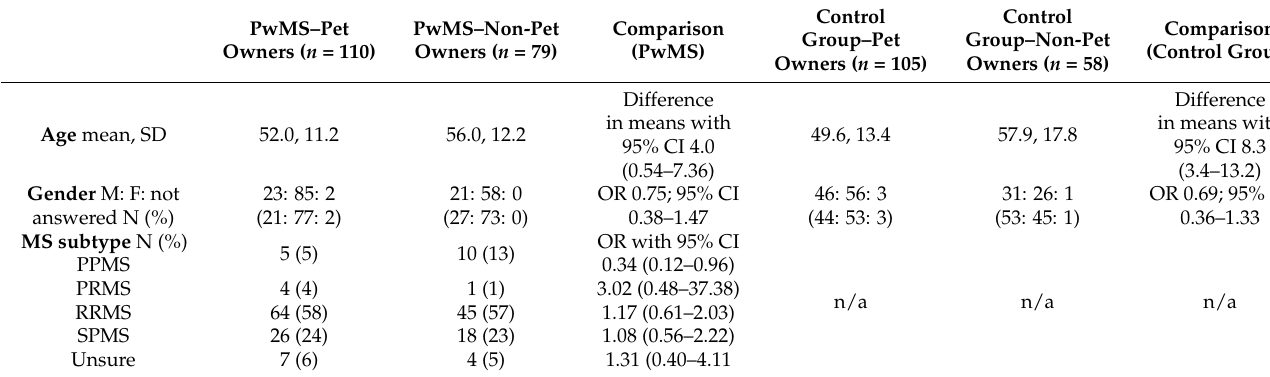
Table 3. Characteristics of pet owners and non-pet owners in the patient and control groups.